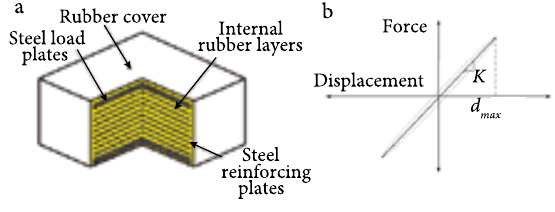
Fig. 1. Formation (a) and analysis model and theoretical hysteresis curve (b) of the RB